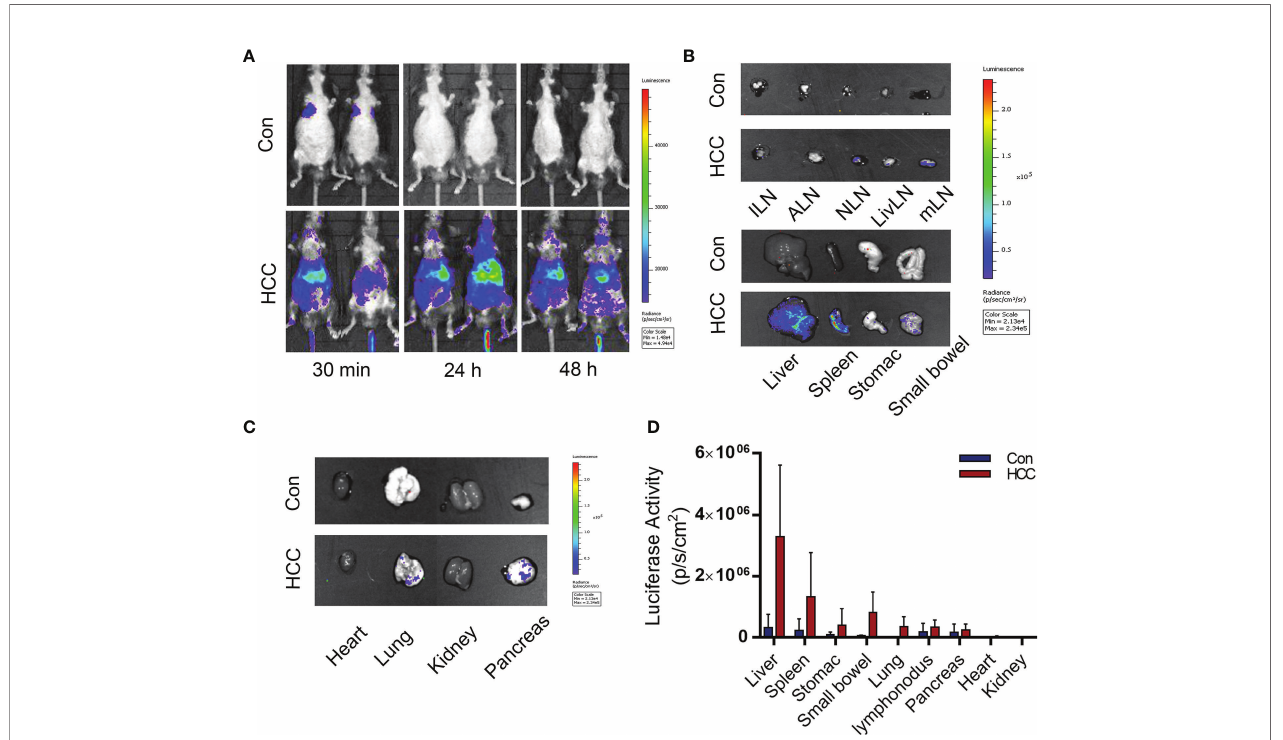
FIGURE 7 | Distribution of Arg1EP-Luciferase-GFP/Raw264.7 in the control and tumor-bearing mouse model. (A) Distribution of Arg1EP-Luciferase-GFP/Raw264.7 in mice from 30 min to 48 h point after cell injection. (B, C) Arg1EP-Luciferase-GFP/Raw264.7 mainly distributed in the liver and spleen of tumor-bearing mice. (D) Statistical analysis of the luciferase activity in major